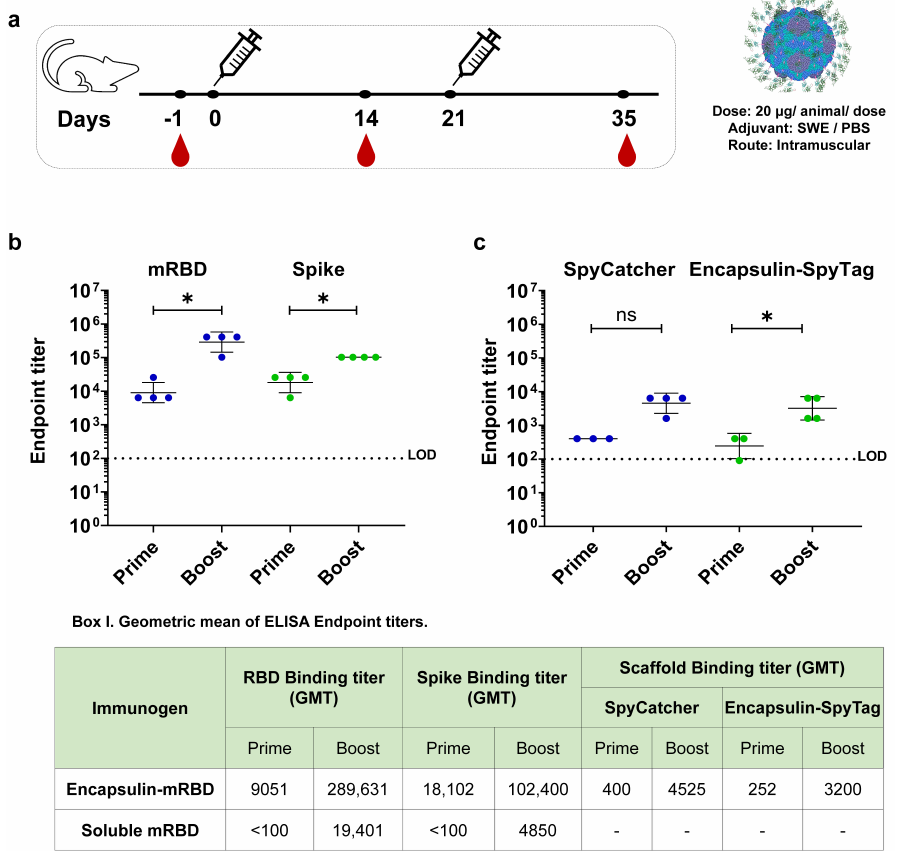
Figure 3. Immunogenicity of encapsulin–mRBD nanoparticles in mice. ( a ), Immunization scheme. ( b ), ELISA endpoint titers of encapsulin–mRBD nanoparticle elicited antisera against mRBD (blue) and spike protein (green) two weeks after prime and boost immunizations. ( c ), ELISA endpoint titers in the sera elicited by encapsulin–mRBD against the scaffold proteins–SpyCatcher and encapsulin– SpyTag measured two weeks after prime and boost immunizations. Binding antibody titers between groups were compared using two-tailed Mann–Whitney tests (* indicates p < 0.05 and ns indicates not significant). LOD is limit of detection. Geometric mean titers (GMT) of serum antibodies binding each protein two weeks after each immunization are indicated in Box